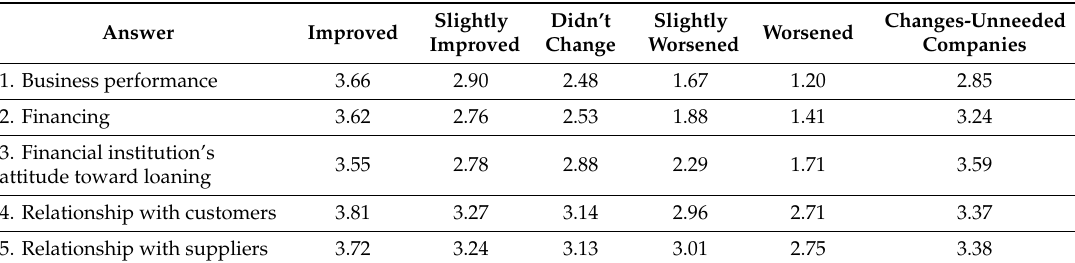
Table 5. Current business states. 1